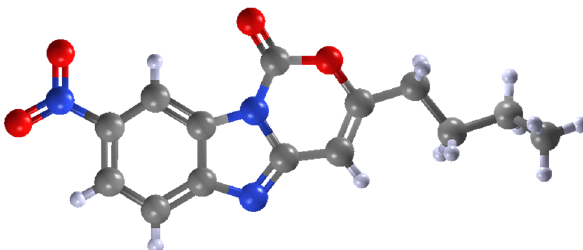
Figure 2. Molecular structure of 3-butyl-8-methoxy-1 H -benzo[4,5]imidazo[1,2- c ][1,3]oxazin-1-one 2c . Color legend: carbon (light grey), hydrogen (white), oxygen (red), nitrogen (blue) (CCDC 2051334).